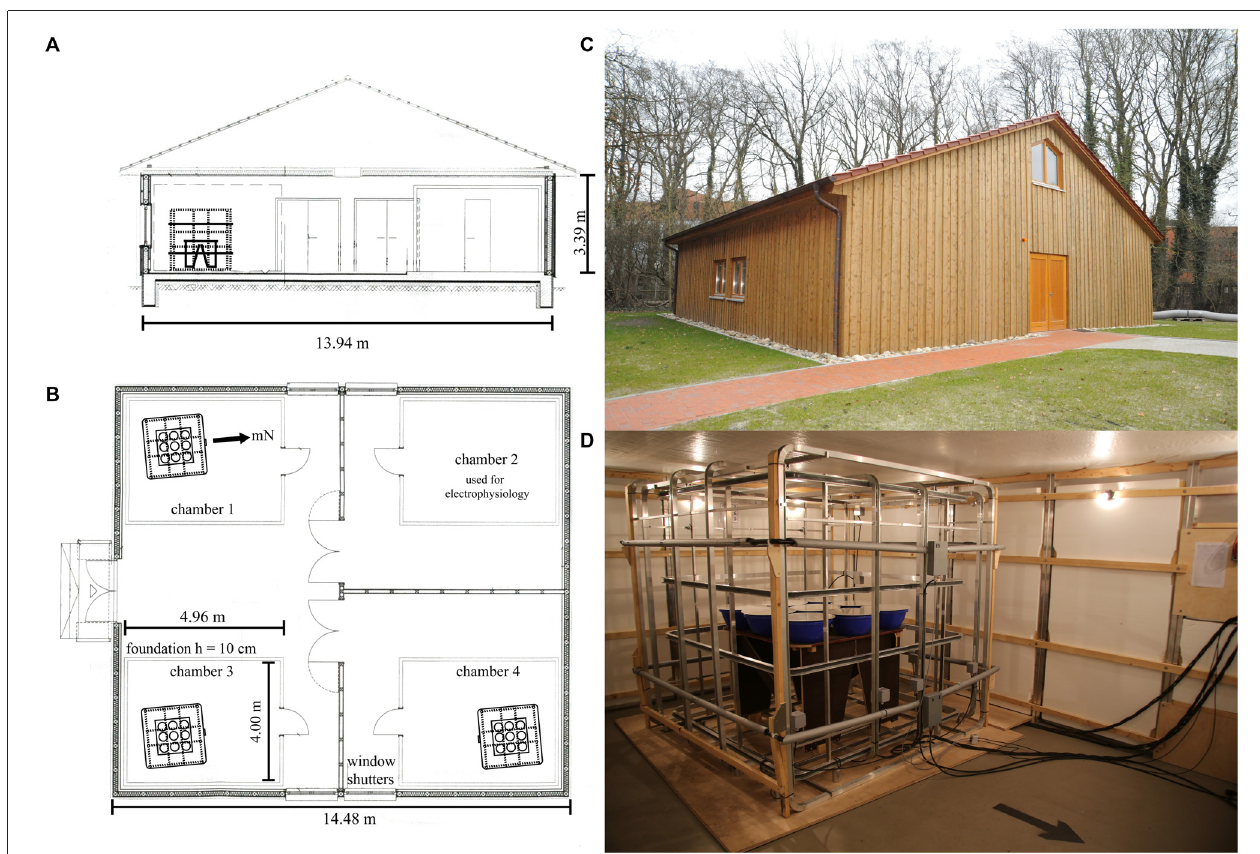
FIGURE 1 | Ground plan of the new wooden laboratory . The materials used to build the laboratory were strictly non-magnetic. Four experimental chambers, which very efficiently screen time-dependent electromagnetic fields, are placed within the building. One double-wrapped, three-dimensional Merritt four-coil system with average coil diameters of ∼ 2 m (Zapka et al., 2009; Hein et al., 2010; Engels et al., 2014) and a pair of 2.2 m z -axis RF-coils in Helmholtz-configuration was placed within three of these four chambers. (A) Cross-section. (B) Floor plan. (C) Photo of the new wooden laboratory from the outside. (D) Photo of one of the coil setups placed inside each of the three chambers. The photo also shows the nine Emlen funnels in their holders, which were placed on top of the wooden table in the center of the coil system.